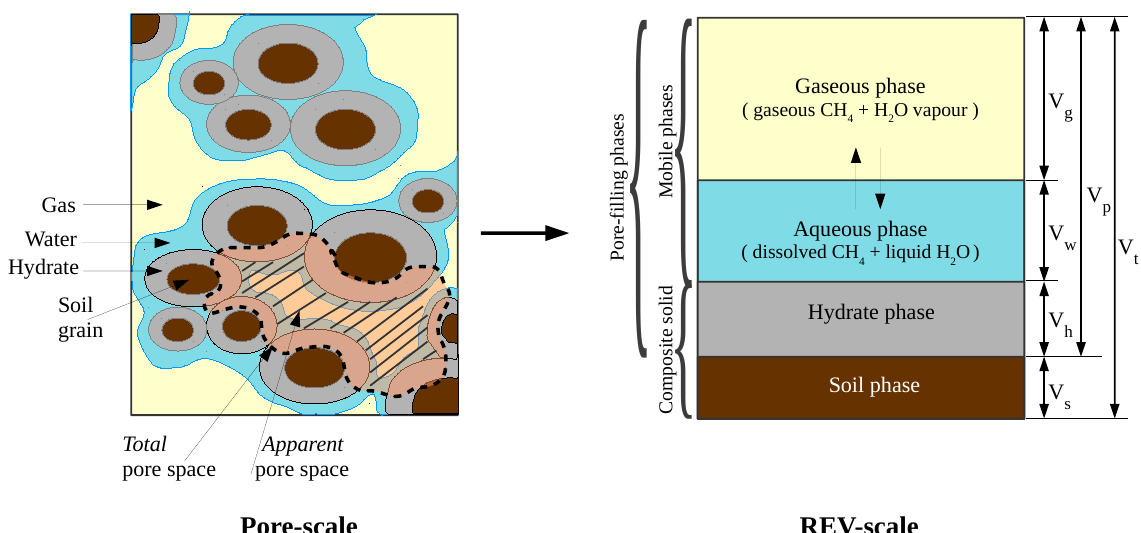
V β . Total and apparent porosites are V p